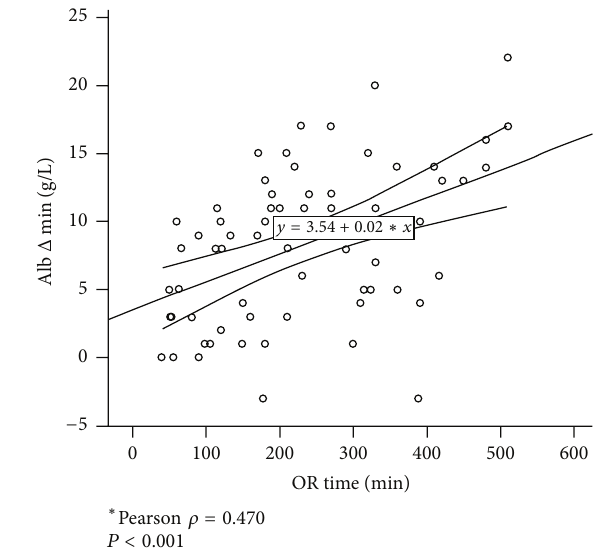
Figure 4: Correlation between albumin drop and operative time. Postoperative albumin decrease (Alb Δ min) is significantly corre- lated with operative time (Pearson 𝜌 = 0.470 , 𝑃 < 0.001 ).